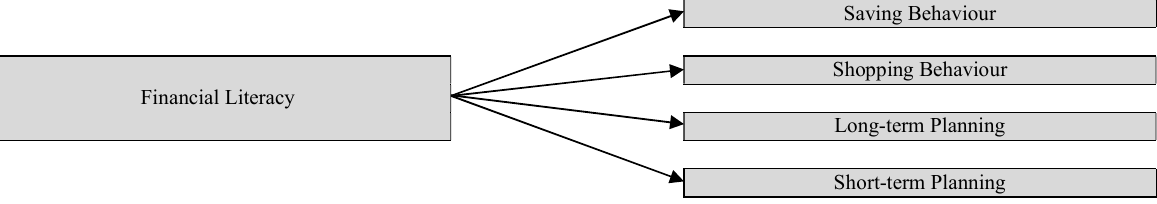
Fig. 1. Conceptual Framework